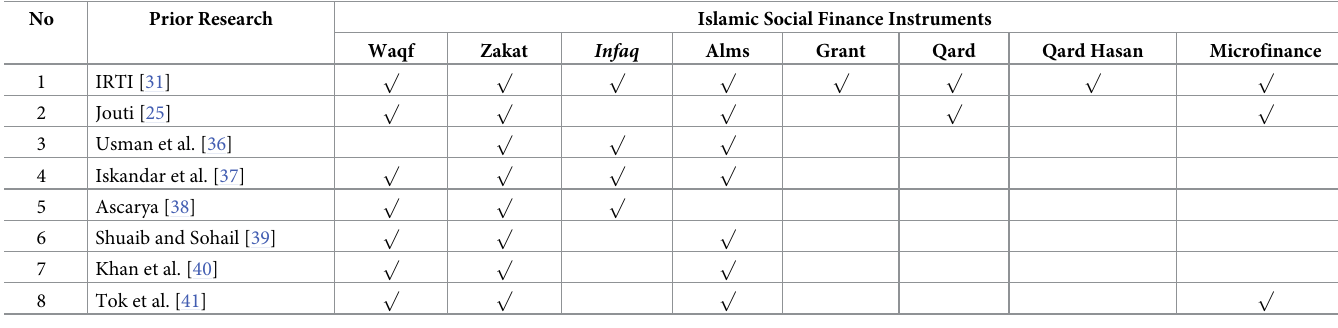
Table 1. Instruments of Islamic Social